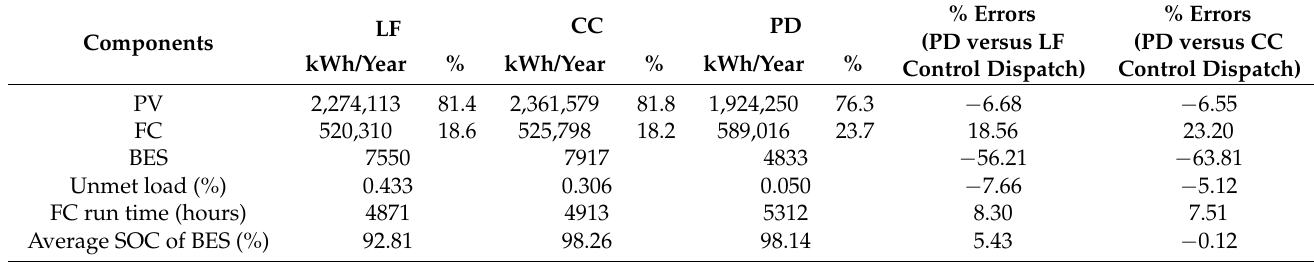
Table 5. Electricity production results for one year for the LF, CC, and PD dispatch strategies.